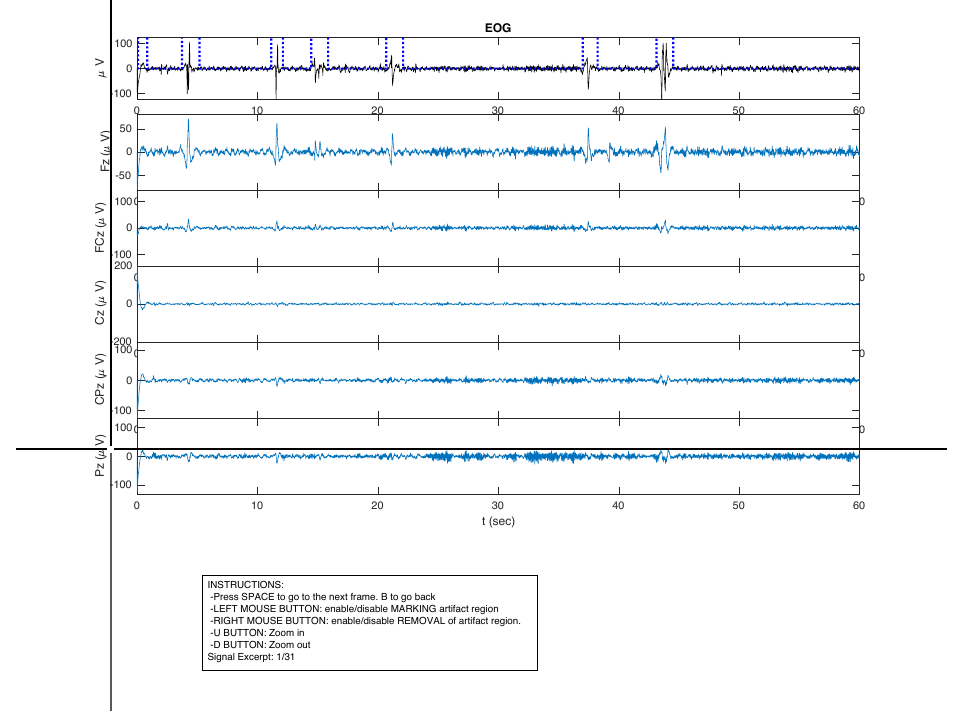
Figure 2. Snapshot of the tool developed for manual eye artifact annotation; the cross is used to mark/unmark excerpts of arbitrary duration. Excerpts are marked over the EOG channel